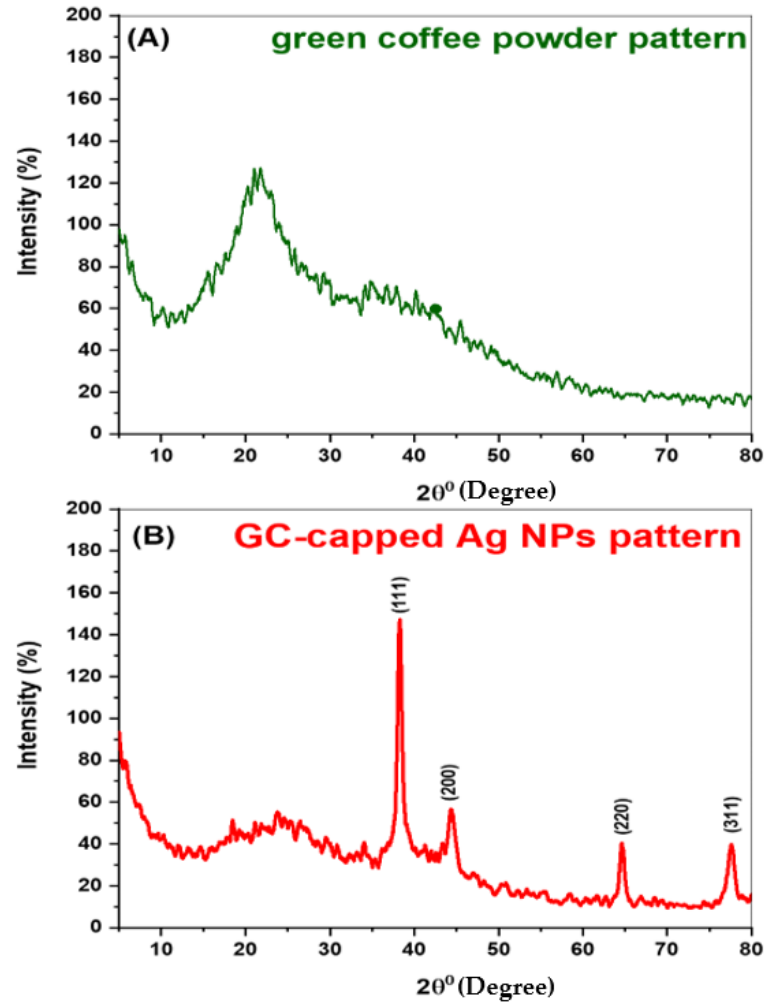
Figure 7. XRD patterns of green coffee beans powder ( A ) and Ag NPs ( B ). In colloidal solutions, DLS was used to analyze quantitative size distributions and a more accurate number of monodispersed particles. Figure 8A indicates that at two separate peak positions, the average particle size was 5.0 and 31.4 nm, with intensity percentages of 5.5 and 94.5%, respectively. With a polydispersity index (PDI) of 0.377, the auto-calculated Z-average was 29.9 nm. At 25 ◦ C, the zeta potential (ZP) was determined to be − 16.4 mV, Figure 8B, indicating the potential stability of the colloidal solution. Phyto-synthesized Ag NPs with Pterodon emarginatus [52], Juglans regia [53], and Punica granatum [54] had PDI values of 0.372, 0.4, and 0.54, and ZP values of − 23.9, − 33.8, and − 34.3 mV, respectively. The DLS results support the polydispersity and long-term stability of phyto-synthesized green coffee Ag NPs. The Z-average of the particles was very close to the data obtained by SEM results.